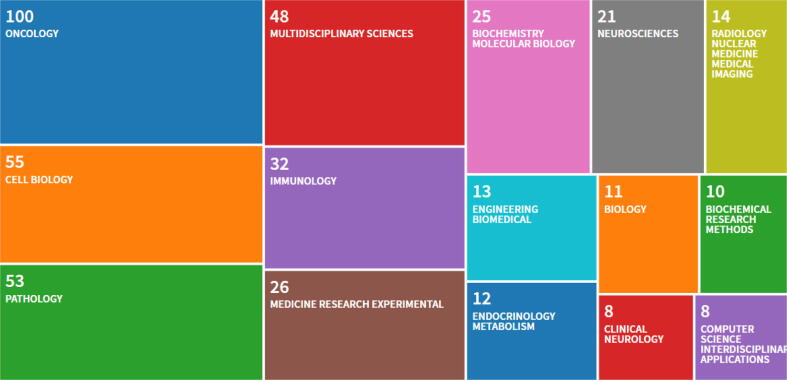
QuPath Research Areas. A treemap visualisation of the 15 top research areas assigned to the publications citing the seminal QuPath paper. Publications are not restricted to a single discipline.